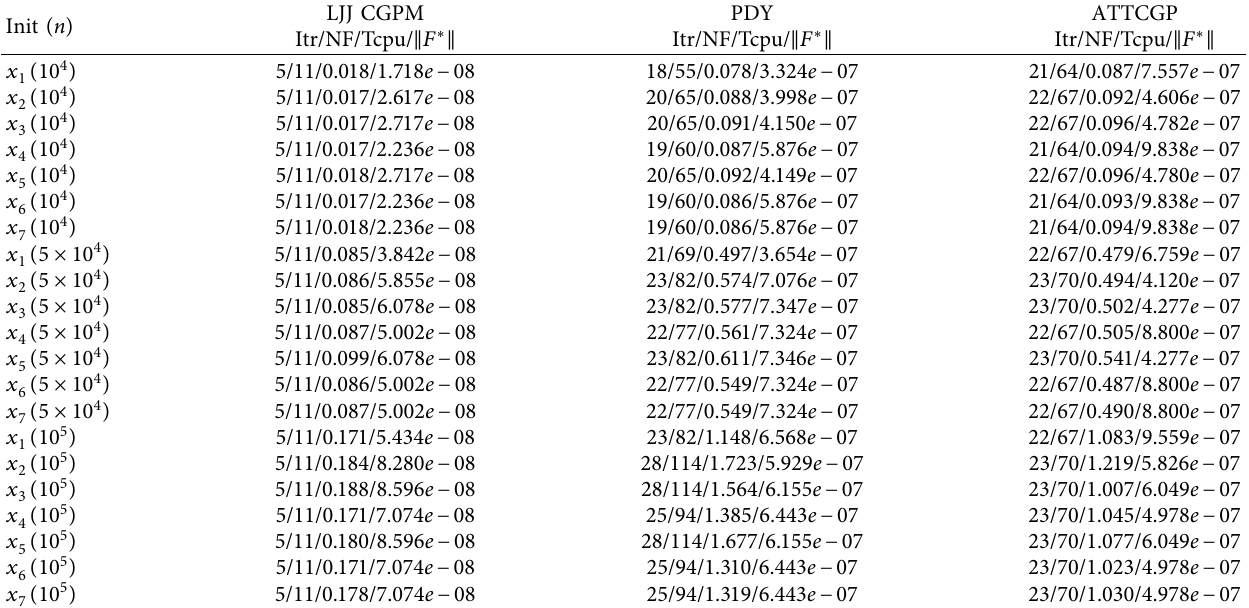
Table 2: Numerical results on Problem